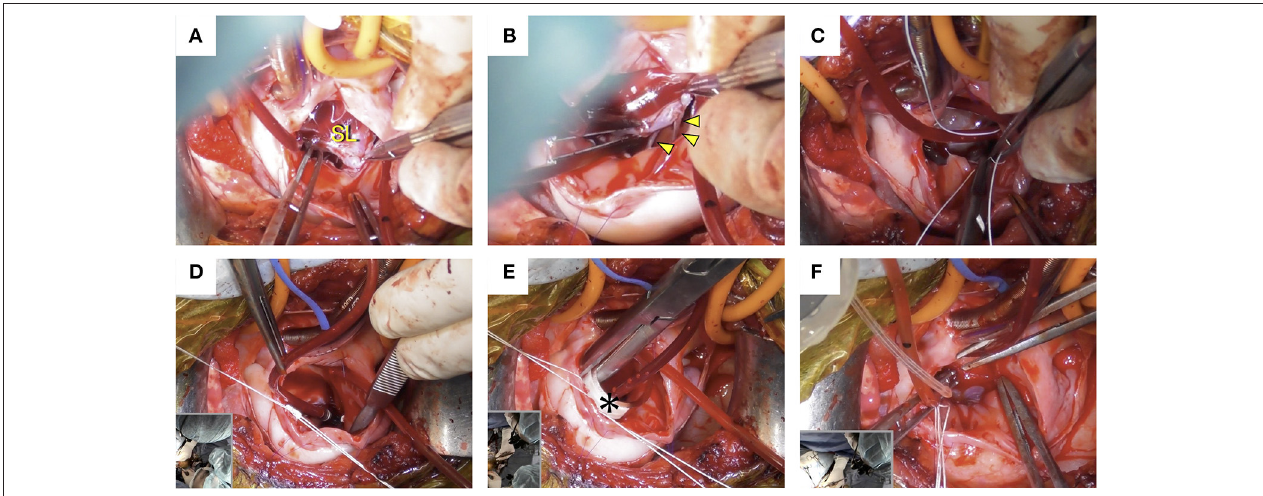
FIGURE 3 | Intraoperative images. (A) The tricuspid valve was confirmed through the opened right atrium. (B) There was no elongation of the chordae tendineae in the tricuspid valve septum (arrowhead) or anterior and posterior leaflets, and no mobility problems were observed. (C) De Vega annuloplasty was performed with a CV-5 extended polytetrafluoroethylene suture. (D) Annular reduction was performed by tying down the plication suture while the cylindrical sizer was inserted into the tricuspid valve orifice. (E) The size of the cylindrical sizer (*) was 16mm, which was set based on the height and width of the septal leaflet. (F) A regurgitation test after tricuspid annuloplasty was performed using saline, and the tricuspid valve was confirmed to be well closed. SL, septal leaflet.